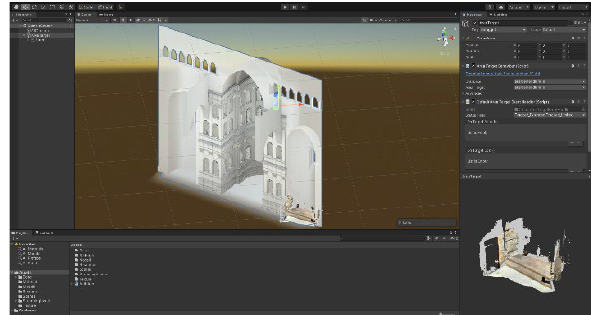
Figure 10. In Unity the 3D reconstruction model is aligned to the 3D data taken with the Area Target tool of Vuforia